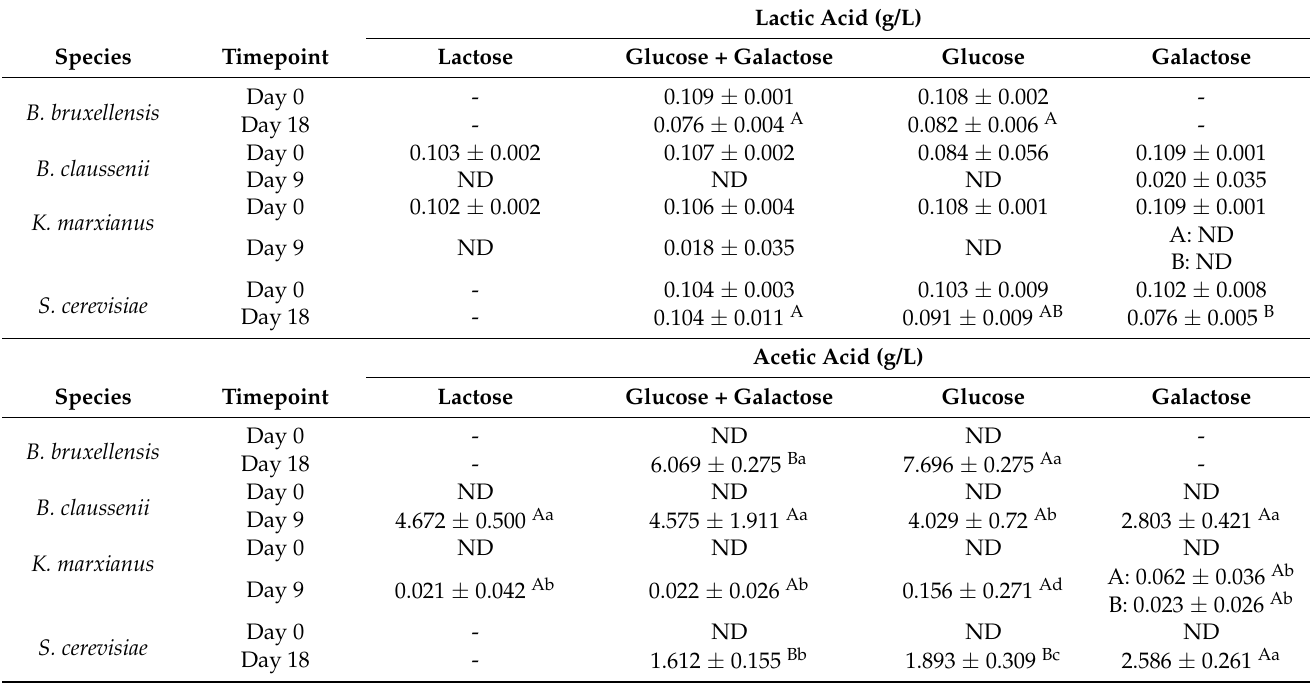
Table 3. Initial and final concentrations of lactic acid and acetic acid in fermentates containing sugars associated with acid whey; fermentates were held at 25 ◦ C and subjected to shaking at 185 rpm. Means and standard deviations are provided, representing biological triplicates, with the exception of values associated with K. marxianus , for which a fourth replicate was included in the